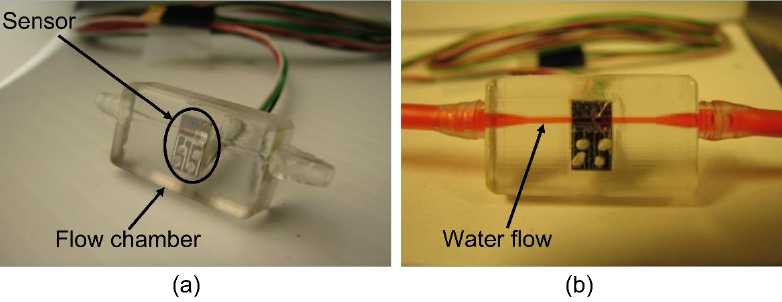
( b ) Colored water runs through the fluid passage of the